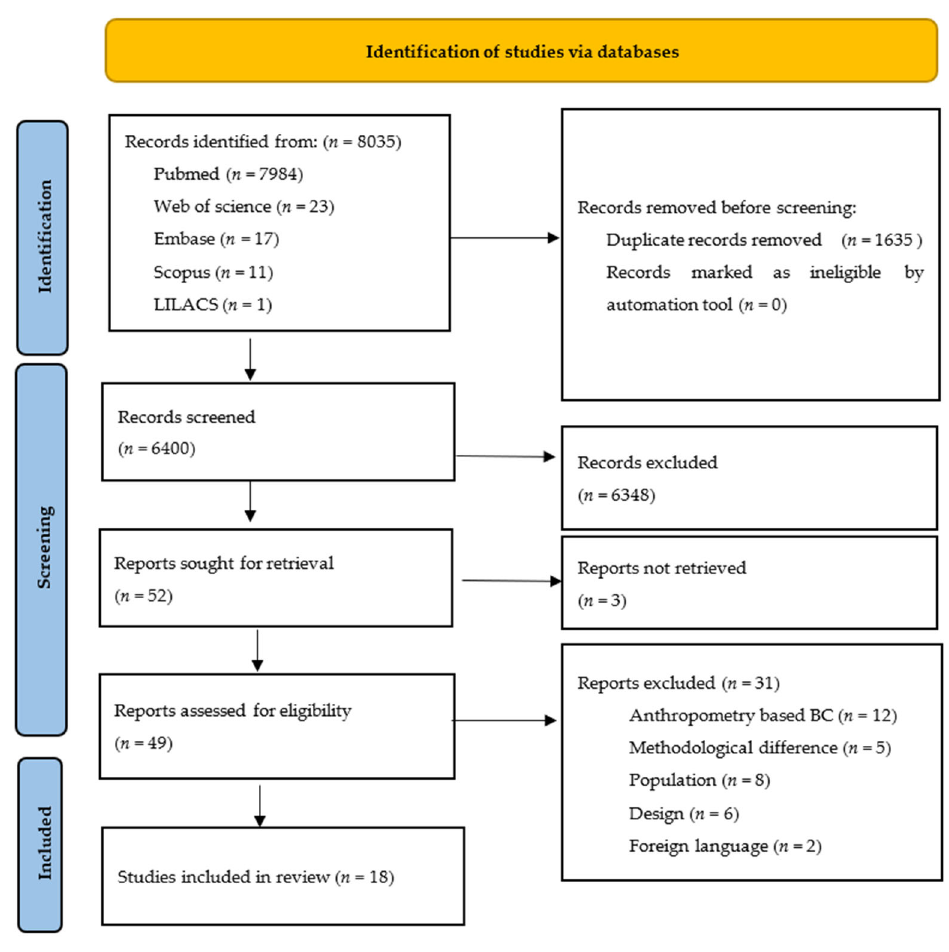
Figure 1. PRISMA screening flowchart.